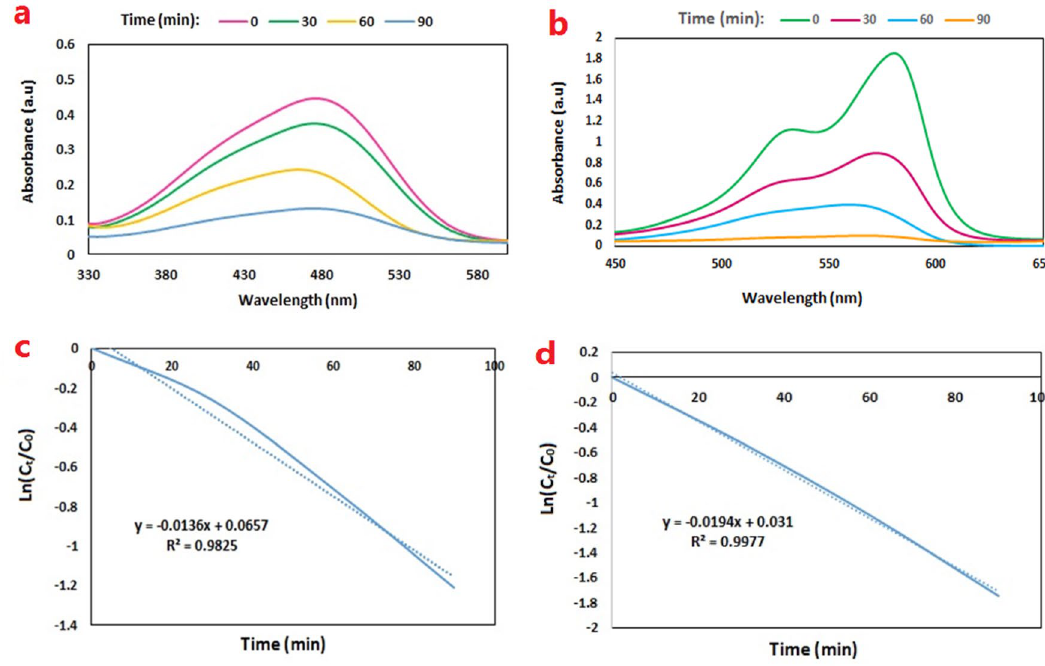
Figure 10. Photocatalytic removal of ( a ) MO and ( b ) MB in the presence of Fe 3 O 4 @BNPs-ZnS-CdS and pseudo-first-order kinetic curves for ( c ) MO and ( d ) MB.